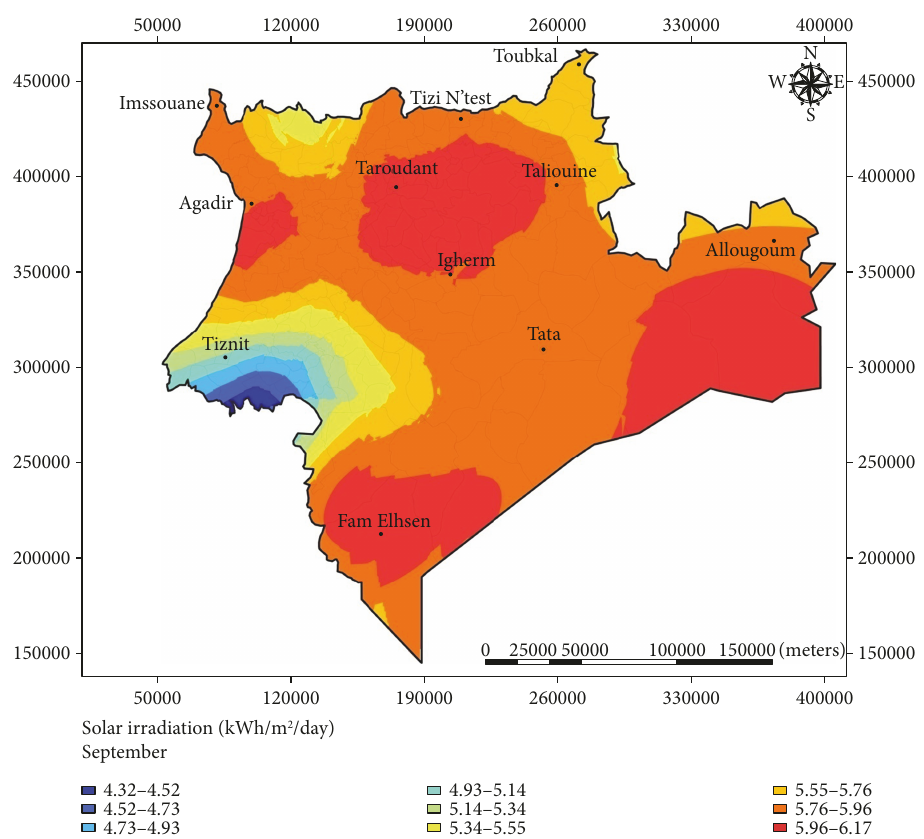
Figure 17: Solar energy potential map of the Souss-Massa area for the month of September as estimated by the ANN and designed with the Kriging interpolation